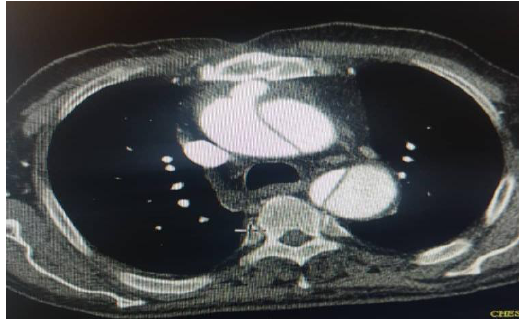
Figure 2. Aortic dissection and skin